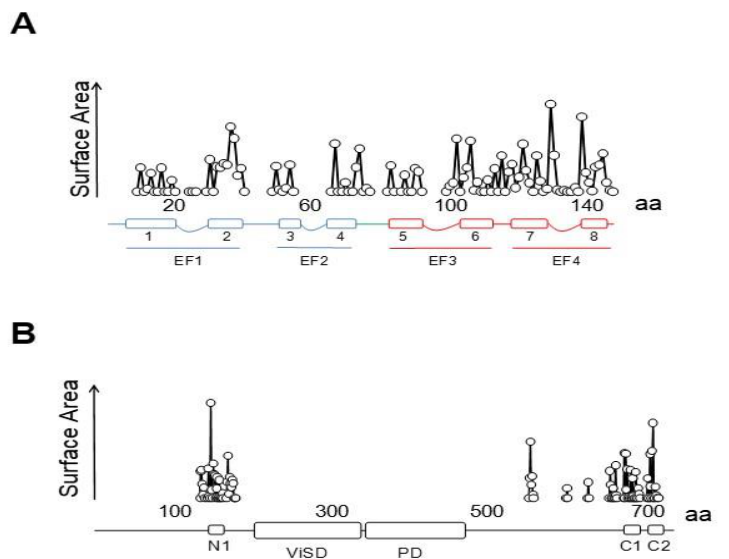
Figure 2. Plot of the contact surface [27] per residue in CaM ( A ) and Eag1 ( B ). Based on PDB 5K7L, 6PBX and 6PBY. “Contact surface area” between atoms A and B is defined as the area of the sphere whose center is the center of atom A and whose radius equals the sum of the Van der Waals radii or atom A and a solvent molecule. The solvent-accessible and contact surface of every atom has been computed using the software made available by Sobolev et al., http: // oca.weizmann.ac.il / oca-bin / lpccsu [27]. + Eag1 is strongly inhibited by Ca 2 -CaM. Combining the expression of WT and CaM-insensitive + subunits at di ff erent ratios, the response to Ca 2 of the resulting heteromeric channels is best described when only one CaM molecule out of the four present in the channel is su ffi cient to shut the pore. + Half inhibition is observed at 70–100 nM Ca 2 , and the suppression is complete above 150 nM [25,29], implying that under native resting conditions most of the channels should be closed (but see